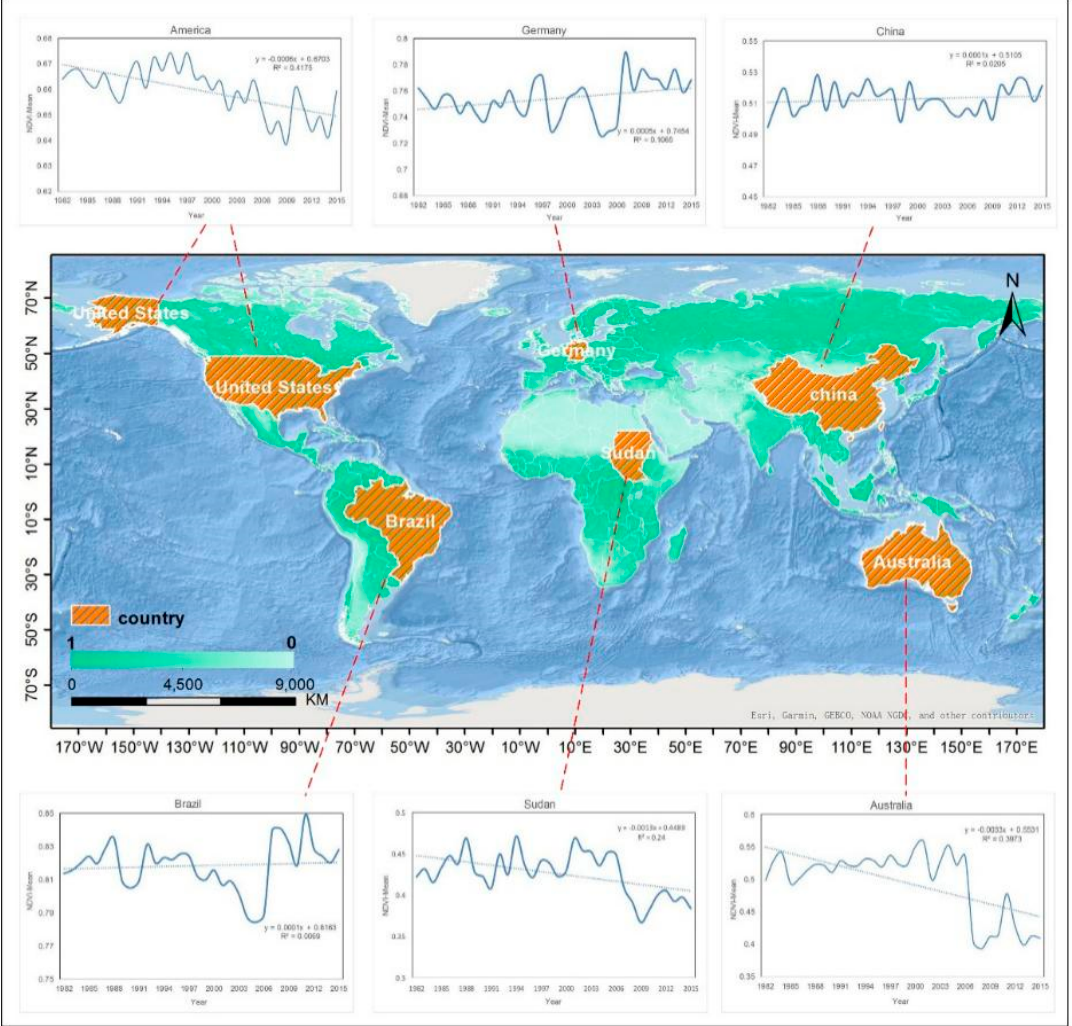
Figure 10. Evolution of NDVI in several countries. (United States, Brazil, Germany, Sudan, China and Australia).